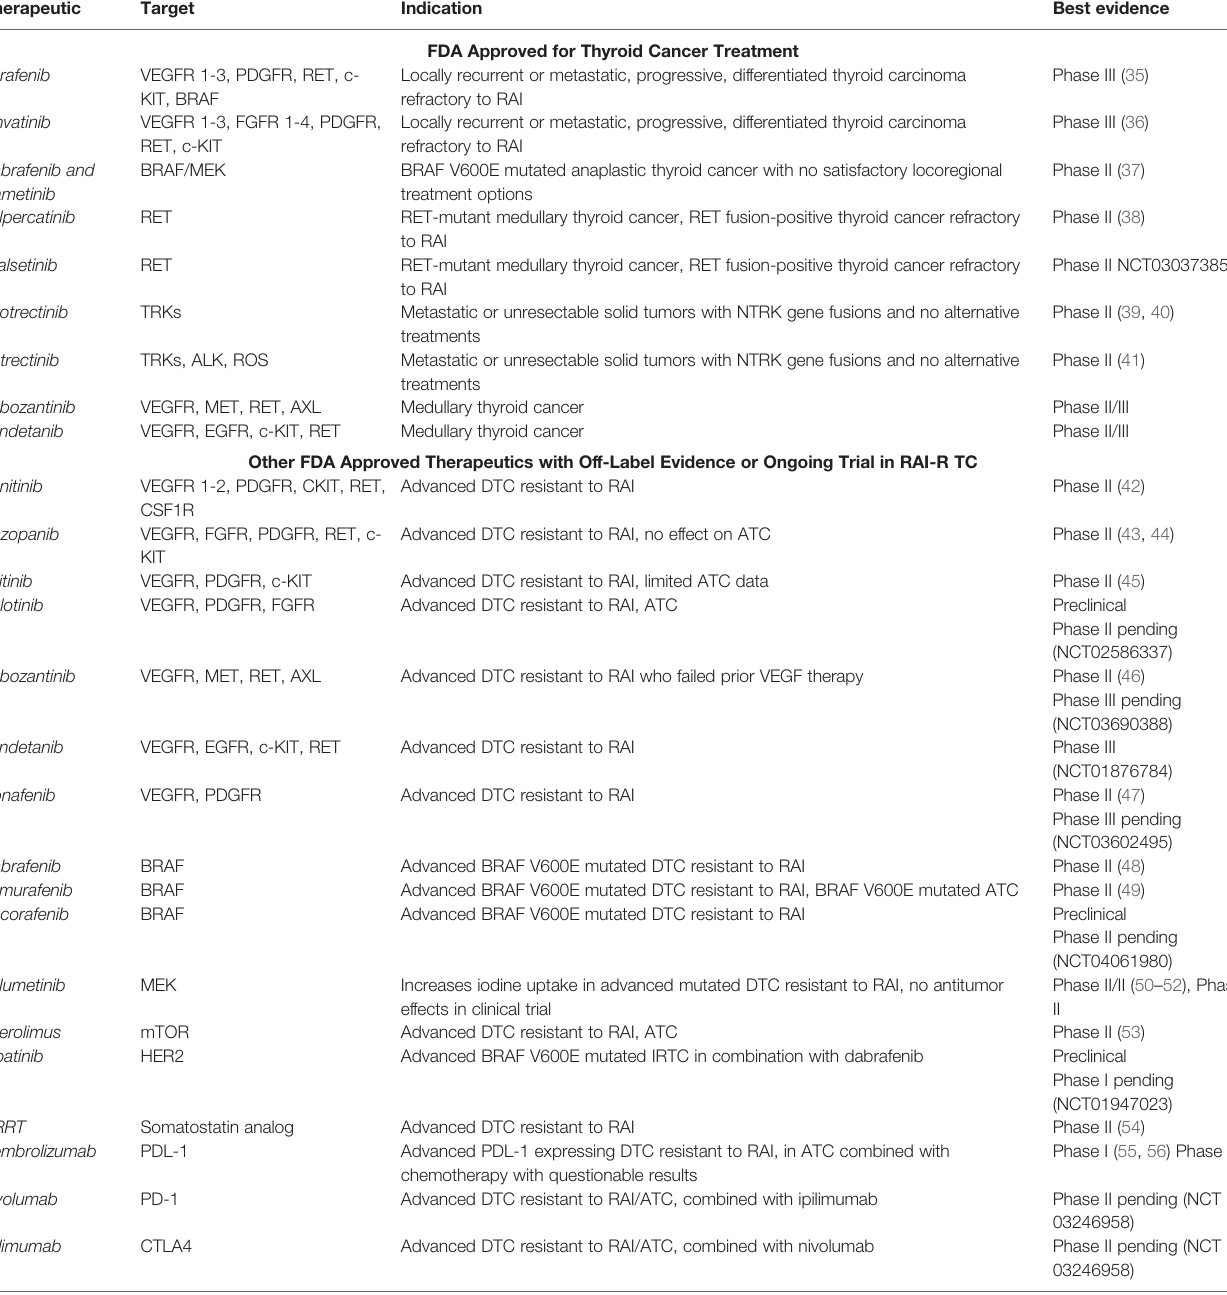
TABLE 2 | Novel Targeted Therapeutics in Iodine Resistant Thyroid Cancer. Therapeutic Target Indication Best